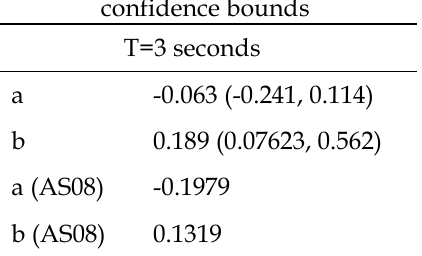
Table 3: Parameters resulting from the residual regres- sion